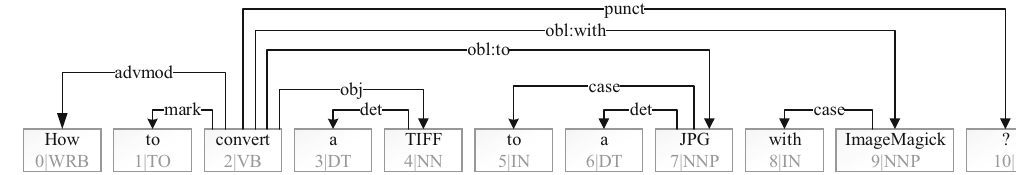
Fig. 3 Example of a syntactic dependency